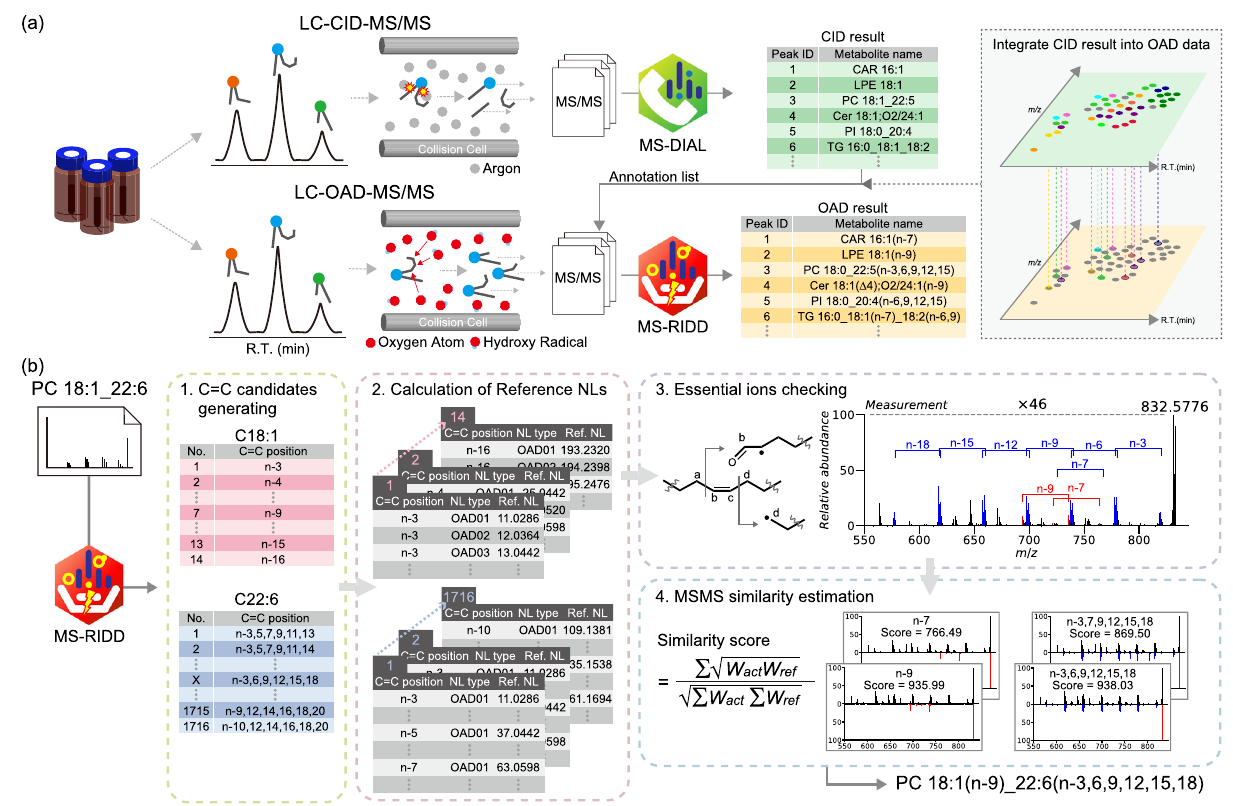
Fig. 2 Integrated strategy using collision-induced dissociation (CID)- and OAD-MS/MS acquisitions for C = C position resolved untargeted lipidomics. a The parallel data acquisition of LC-CID-MS/MS and LC-OAD-MS/MS, and the overview of integrative data handling of both LC-CID-MS/MS and LC- OAD-MS/MS methods. Data preprocessing, including peak picking, MS/MS assignment, and peak alignment, is executed by MS-DIAL for both LC-CID- MS/MS and LC-OAD-MS/MS raw data, and the CID-spectral annotation is also performed in MS-DIAL. The annotated result by molecular species level and the OAD-MS/MS spectra were further processed by the MS-RIDD program. b The core algorithm of MS-RIDD to determine the C = C positions in lipids. The main procedure contains four steps: (1) generating theoretically possible structural candidates based on the information on the lipid molecular species, (2) computing the reference neutral loss list, i.e. in silico tandem mass spectrum, according to the dissociation rules, (3) veri fi cation of essential diagnostic ions in each C = C location, and (4) calculating the MS/MS spectral similarity by reverse dot-product values using square-root-transformed intensity to prioritize the structural